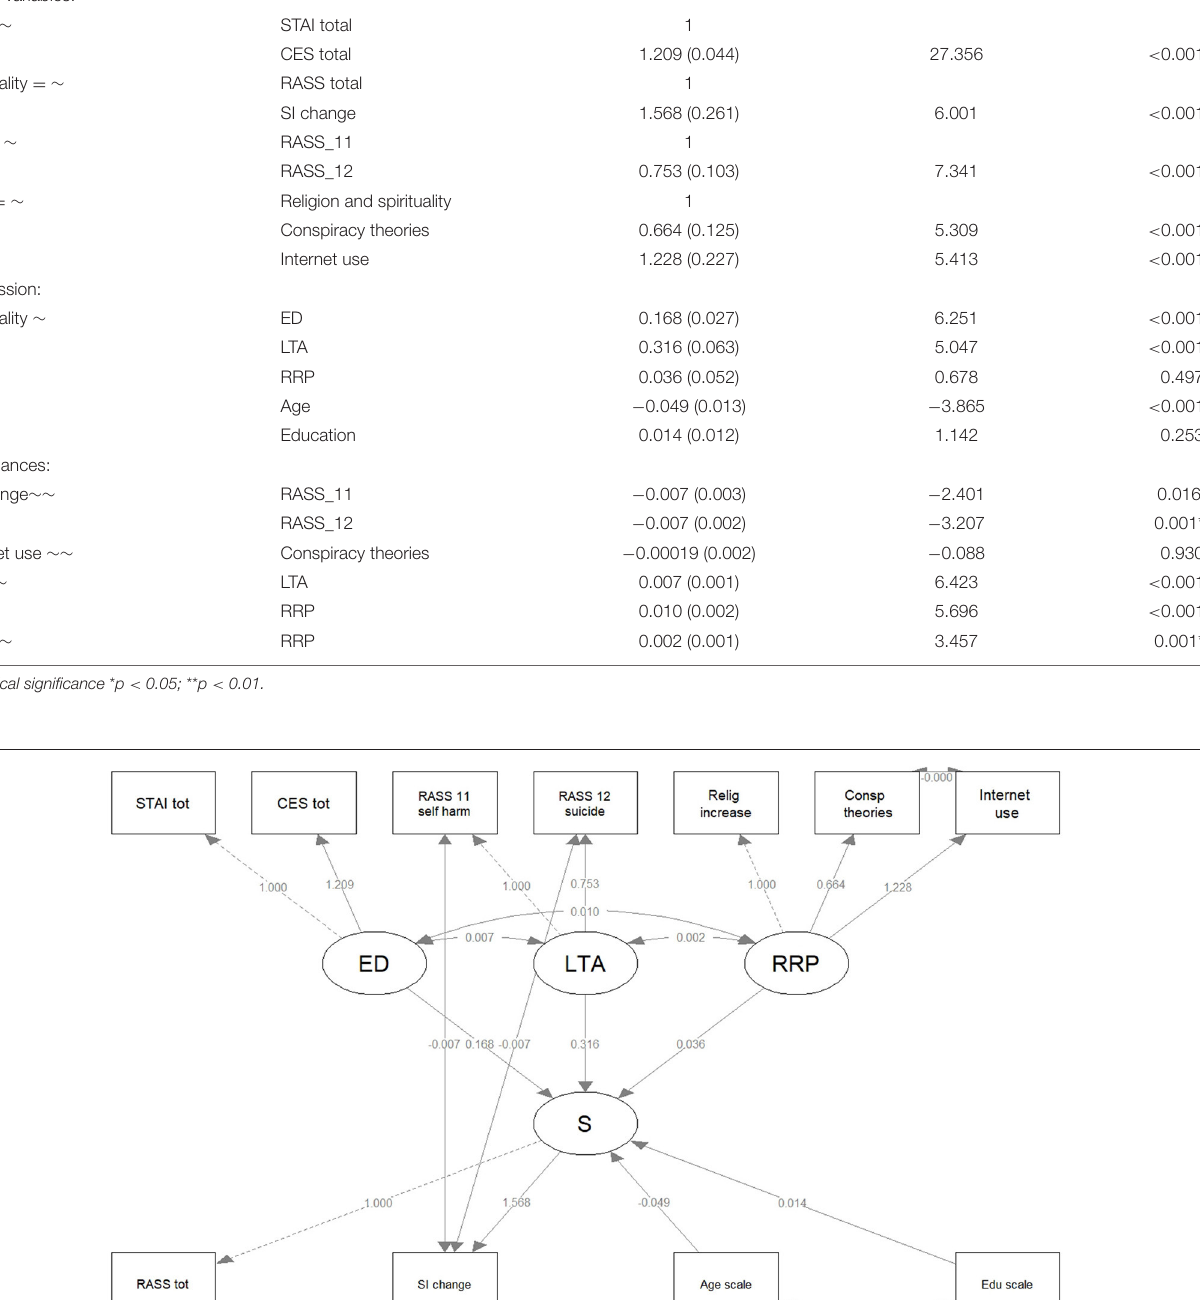
Frontiers in Psychiatry |